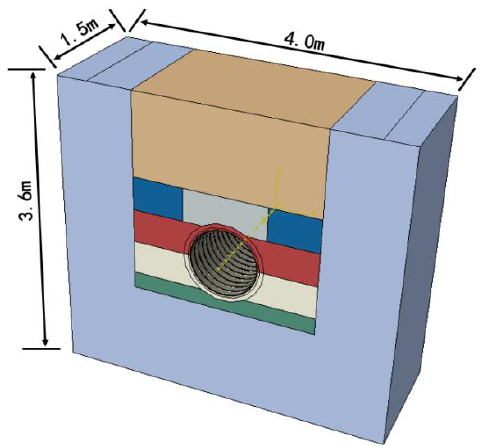
Figure 6. Three-dimension model of the pipe and surrounding soil.